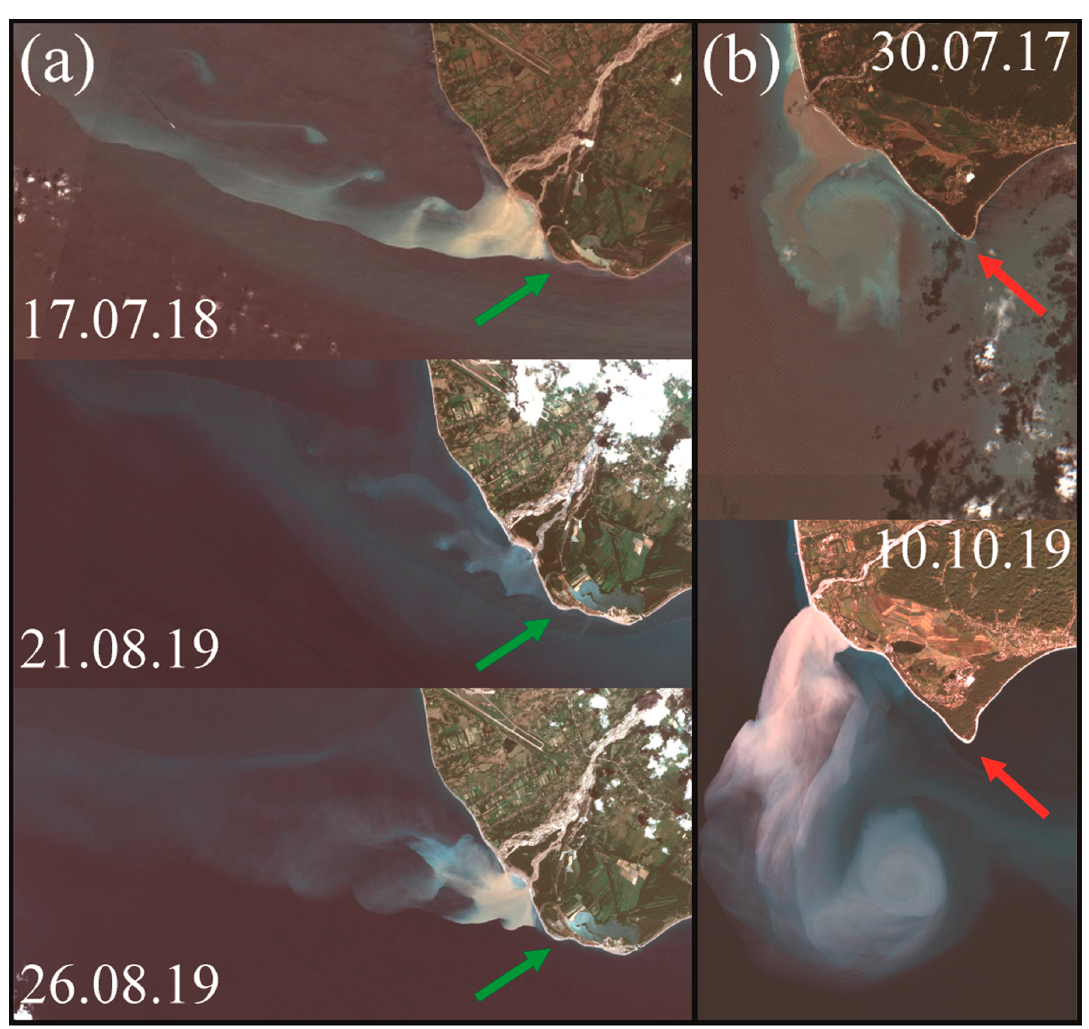
Figure 8. Sentinel-2 ocean color composites ( a ) from 17 July 2018, 21 August 2019, and 26 August 2019 illustrating interactions between eddies and the Kodor plume and ( b ) from 30 July 2017 and 10 October 2019 illustrating interactions between eddies and the Bzyp plume. Green arrows indicate location of the Iskuria Cape and red arrows indicate location of the Pitsunda Cape. Note that images at panels ( a ) and ( b ) are inconsistent, i.e., they show river plumes at different dates.